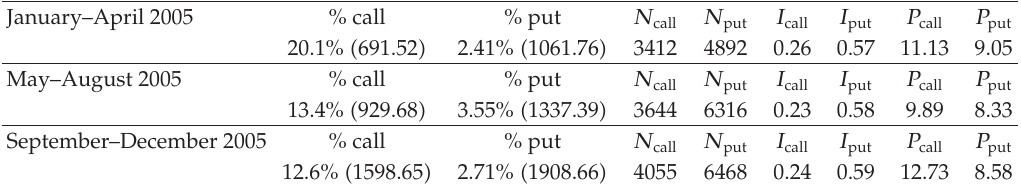
Table 3: S & P 500 option prices: out of the money options (cid:2) year 2005 (cid:3) . These results were obtained using the estimates (cid:2) 4.6 (cid:3) and (cid:2) 4.7 (cid:3)